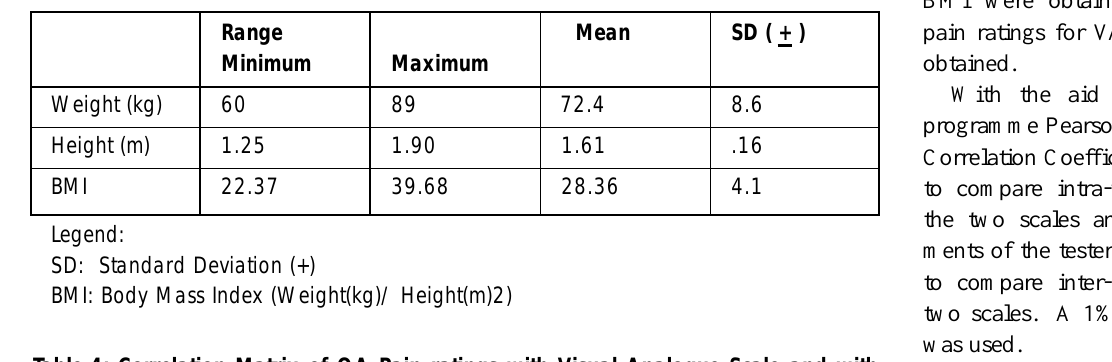
Figure 1: Patient in Forward Upward Step- ping Movement with the Right Leg